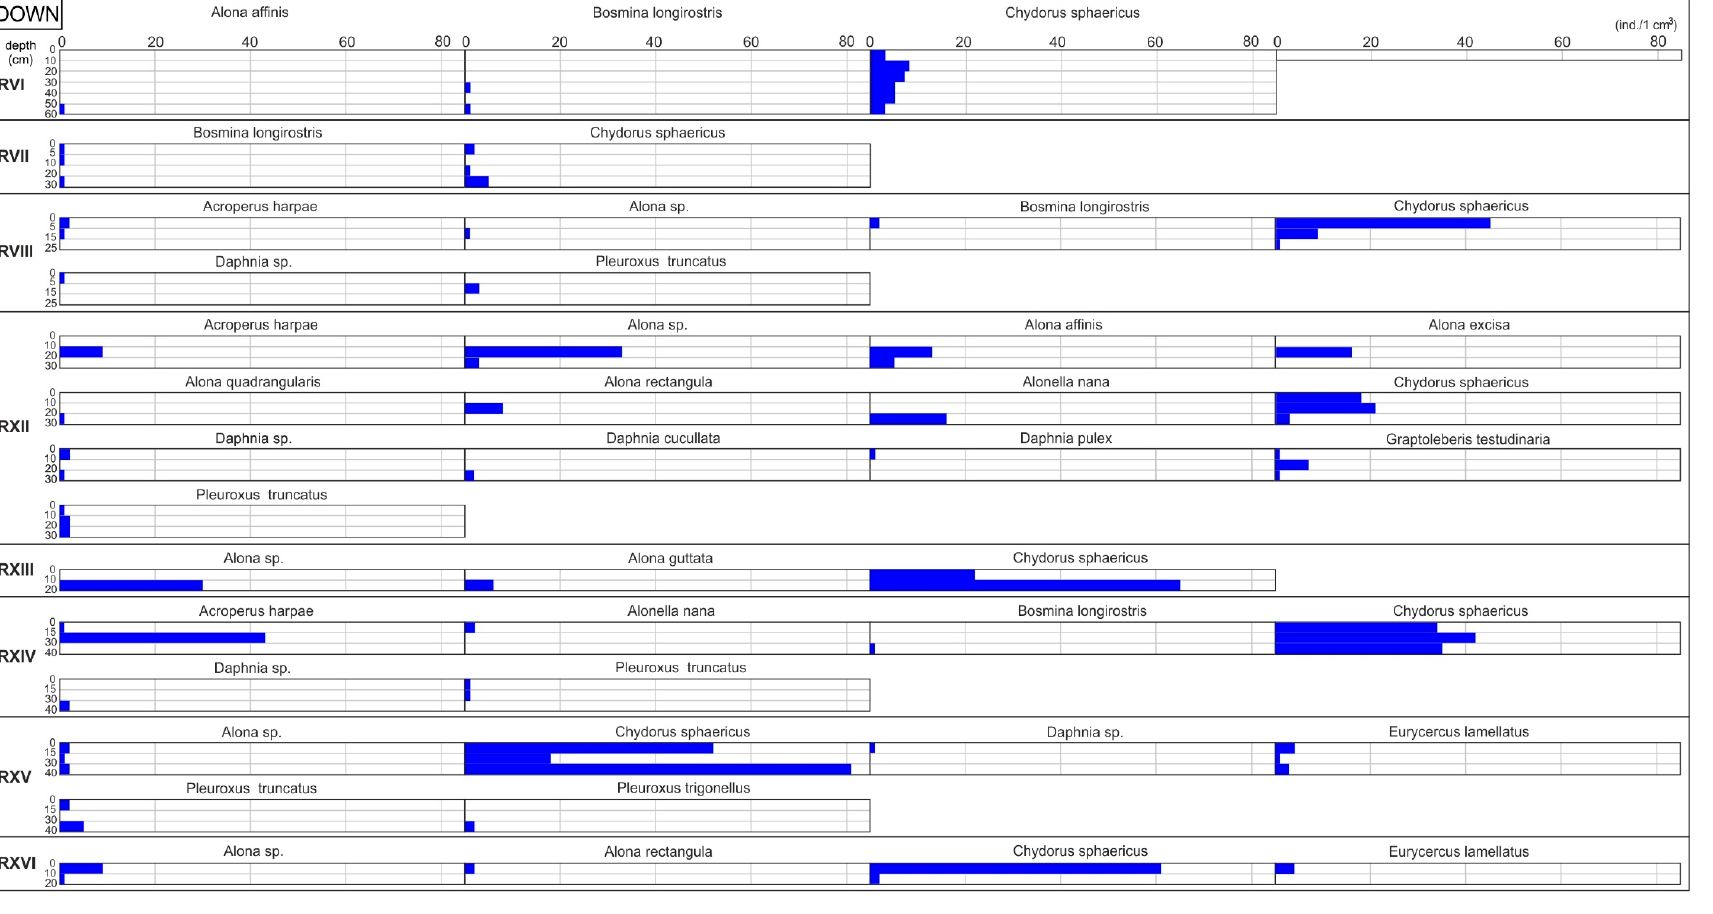
Figure 4. Diagram of the absolute number of Cladocera individuals in 1 cm 3 of sediment from subsidence ponds existed during mine exploitation (DOWN).